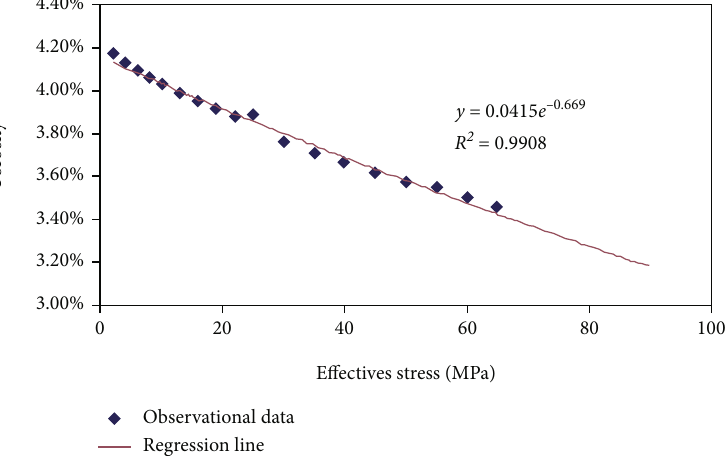
Figure 5: Relationship between porosity and e ff ective stress.